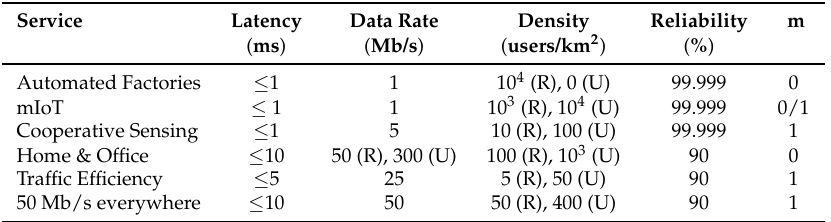
Table 3. 5G service